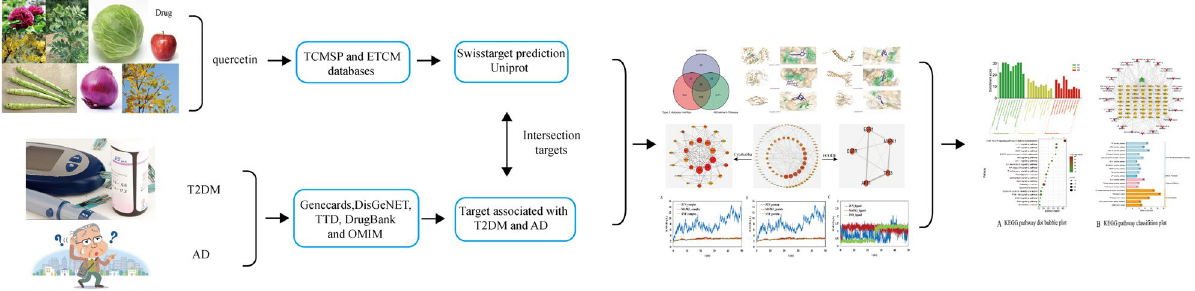
Figure 1. Flowchart of the network pharmacology study investigating quercetin targets for T2DM and AD